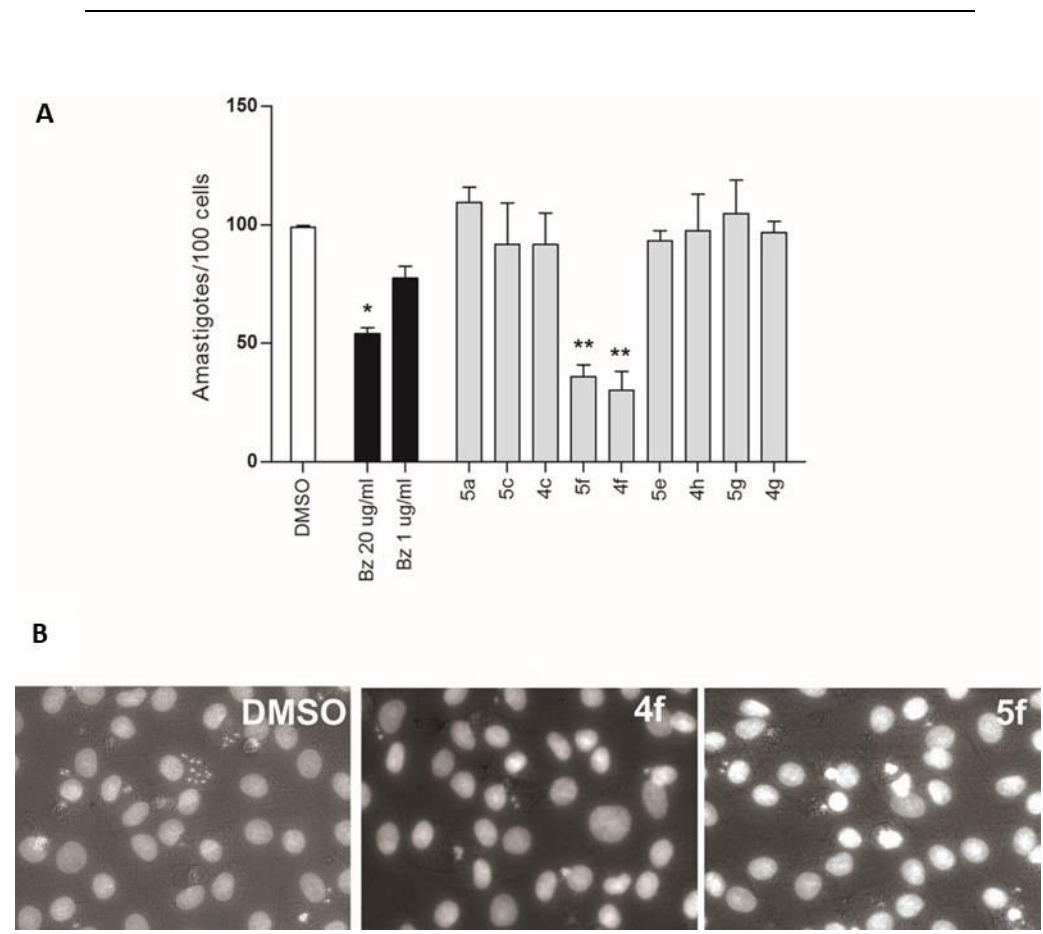
Figure 1. ( A ) Effects of hybrids on intracellular amastigotes. Hybrids were evaluated at the estimated parasite IC 50 concentration for the Y strain (Table 3). Bars indicate mean ± SE of at least three independent assays (see Methods). * p < 0.05, ** p < 0.01. ( B ) Representative microscope photographs of NRK infected cells treated as indicated.